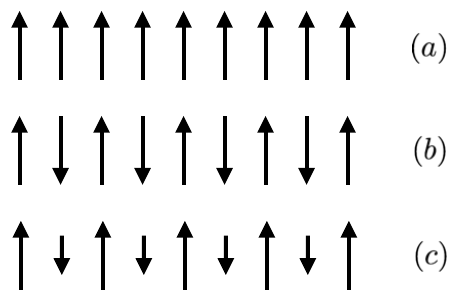
Figure 1: Schematic representation of the ground state spin configuration of ( a ) ferromagnets, ( b ) antiferromagnets, and ( c )